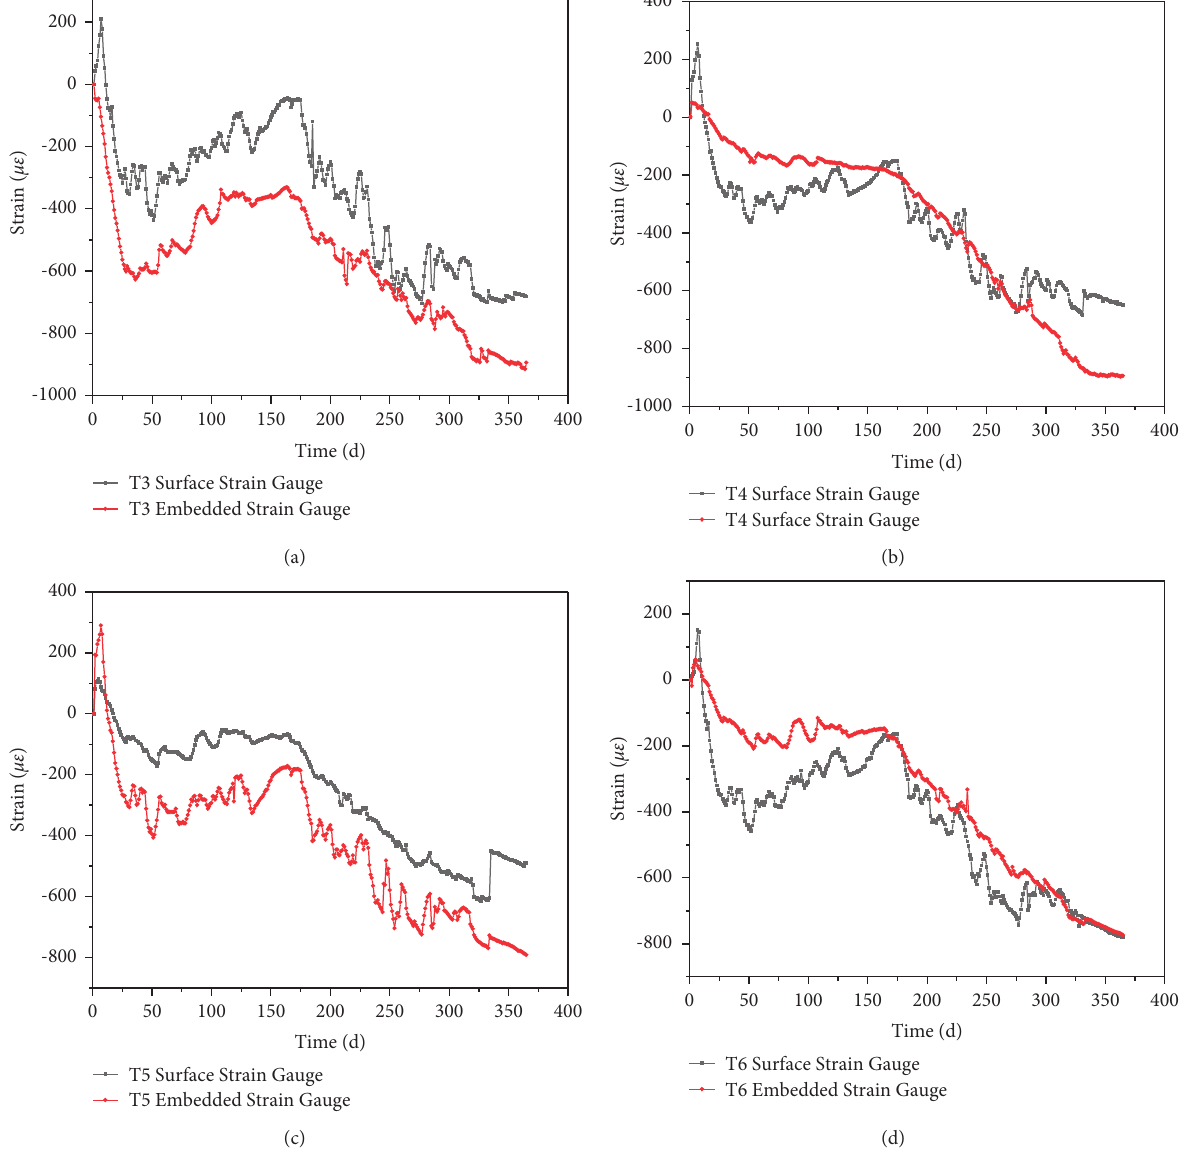
Figure 14: Curve of specimen shrinkage strain with time. (a) T3 specimen. (b) T4 specimen. (c) T5 specimen. (d) T6